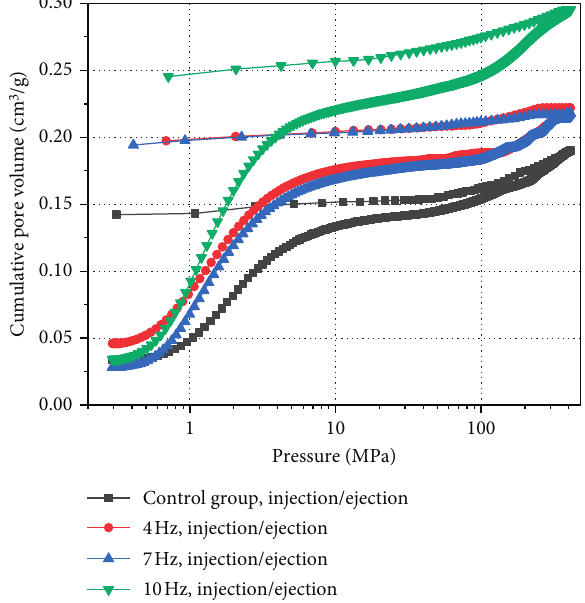
Figure 4: Mercury-intrusion curves of samples at different loading